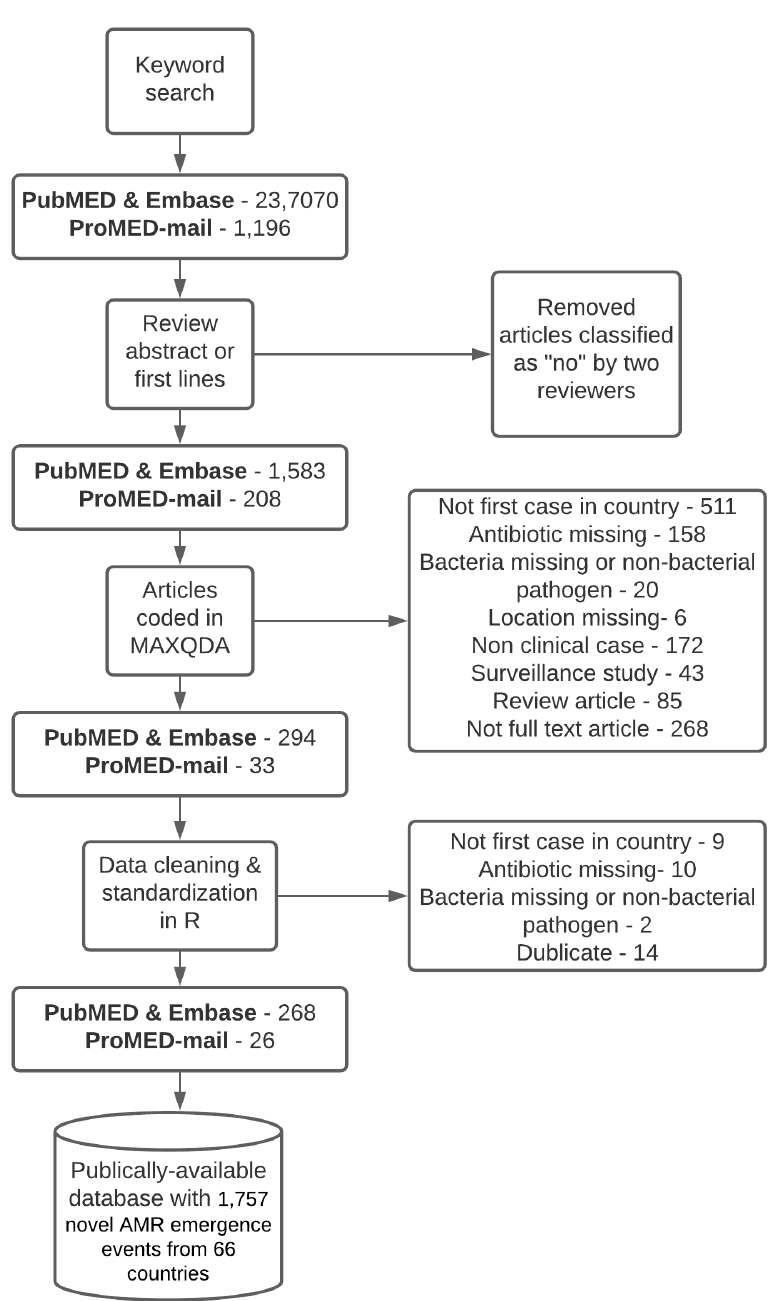
Figure 1. Prisma flow diagram, showing the workflow of information through steps of the systematic review. Note some articles were excluded based on more than one criteria.